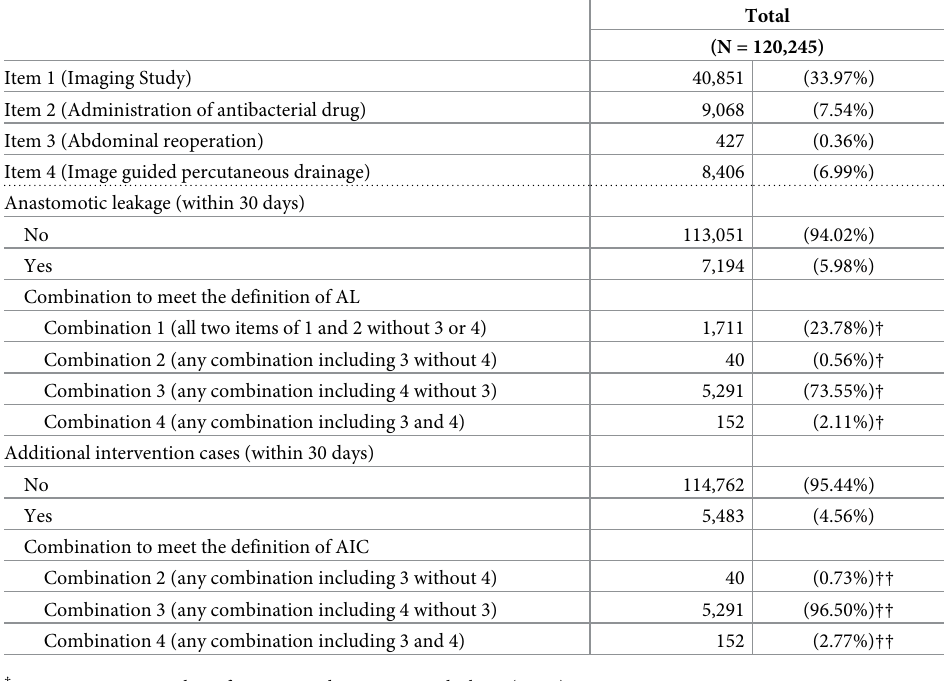
Table 1. Anastomotic leakage and other clinical